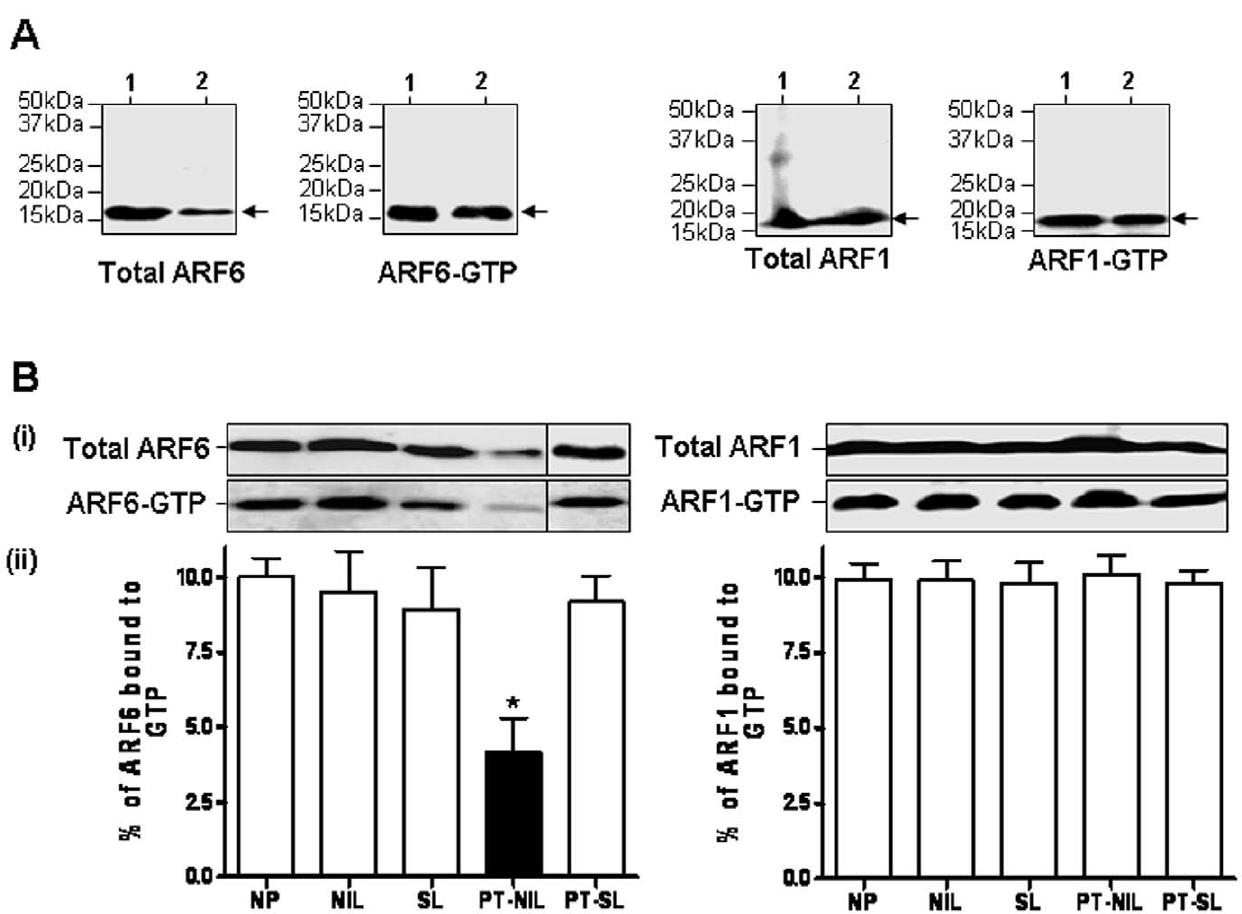
scanning. The data were expressed as percentage of total ARF1 or ARF6 that is GTP bound. The histogram represents an average of 4 samples for each condition